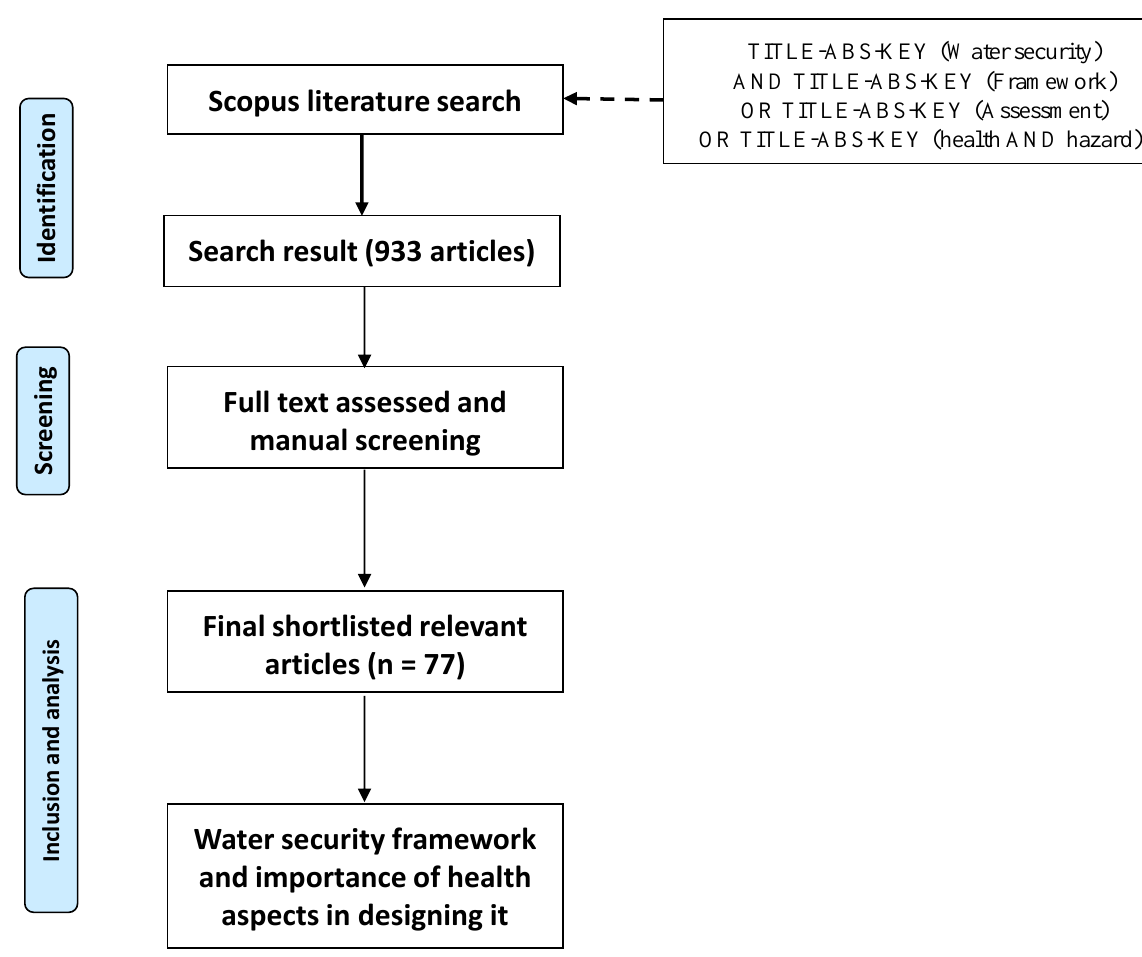
Figure 1. PRISMA flowchart of review results.